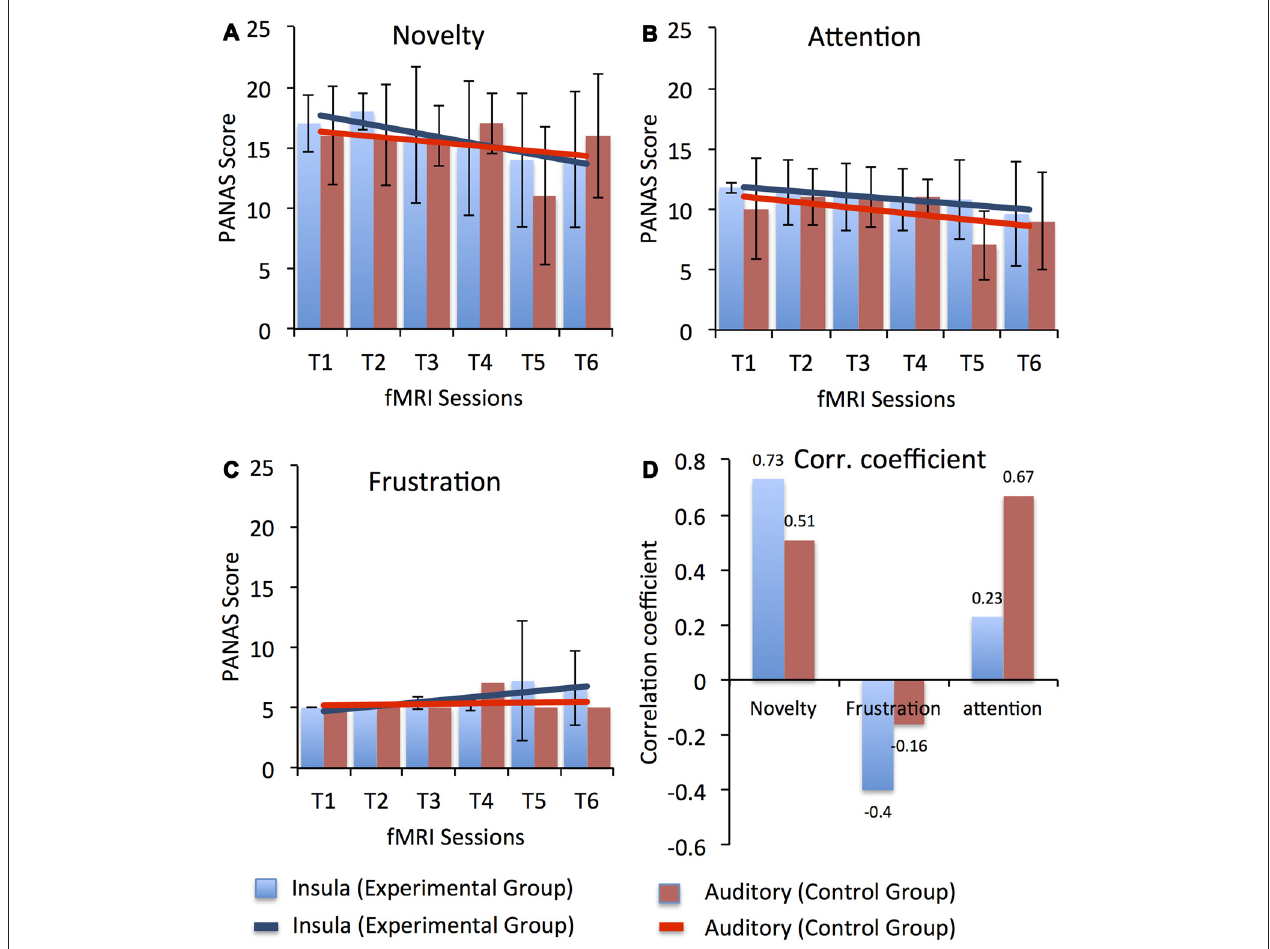
FIGURE 6 | Average Positive Affect and Negative Affect Scale (PANAS) score for three different aspect of participants’ current mood with possible relevance to the learning process, namely, novelty/motivation (comprised the adjectives interested, excited, inspired, enthusiastic, determined), attention (comprised the adjectives alert, attentive, active) and frustration (comprised the adjectives distressed, downhearted, upset, frustrated, irritable) across all fMRI sessions for both the experimental (blue) and the control (red) groups. Scores for novelty, attention and frustration were calculated by averaging across the rating of respective adjectives. Error bars represent the standard deviation in the scores for novelty, attention and frustration across the group. Results from a linear regression analysis are represented by the solid blue and red lines for the experimental and the CGs, respectively. A gradual linear downward trend was observed in the ratings of novelty (A) and attention (B) across the sessions in both groups. However, a minute increase was observed in the ratings of frustration (C) in the later sessions for participants in both groups. High positive correlation coefficients (D) between up-regulation performance (i.e., % change in BOLD signal in bilateral anterior insula for the EG and in bilateral primary auditory cortex for the CG) and the PANAS scores were observed for novelty and attention, indicating that reduced motivation and attention levels might have led to reduced self-regulation performance. In contrast, a negative correlation was observed between PANAS scores for frustration and up-regulation performance in both groups, indicating that frustration did not affect participants’ self-regulation